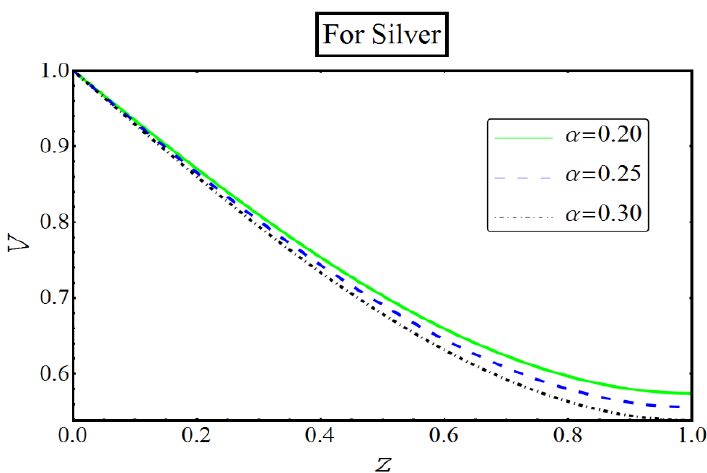
Figure 17. Behavior of azimuthal velocity for the thermocapillary parameter with silver particles.